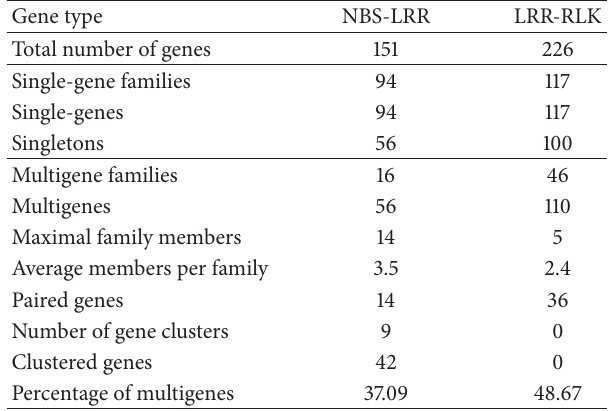
Table 1: The distribution of LRR-receptor genes on maize chromo- some.